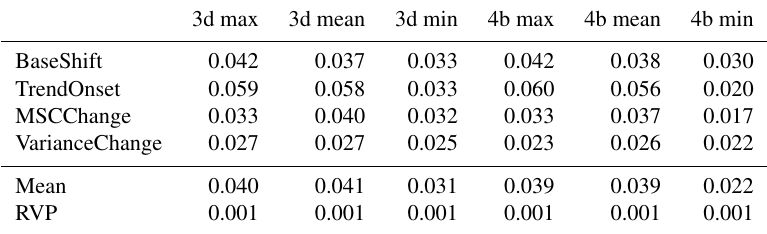
Table 2. AUC difference of the ensembles of anomaly detection algorithms to the UNIV control. Ensembles are computed out of the four best algorithms (4b, KDE, REC, KNN-Gamma, T 2) and the three best distance-based algorithms (3d, KDE, REC,